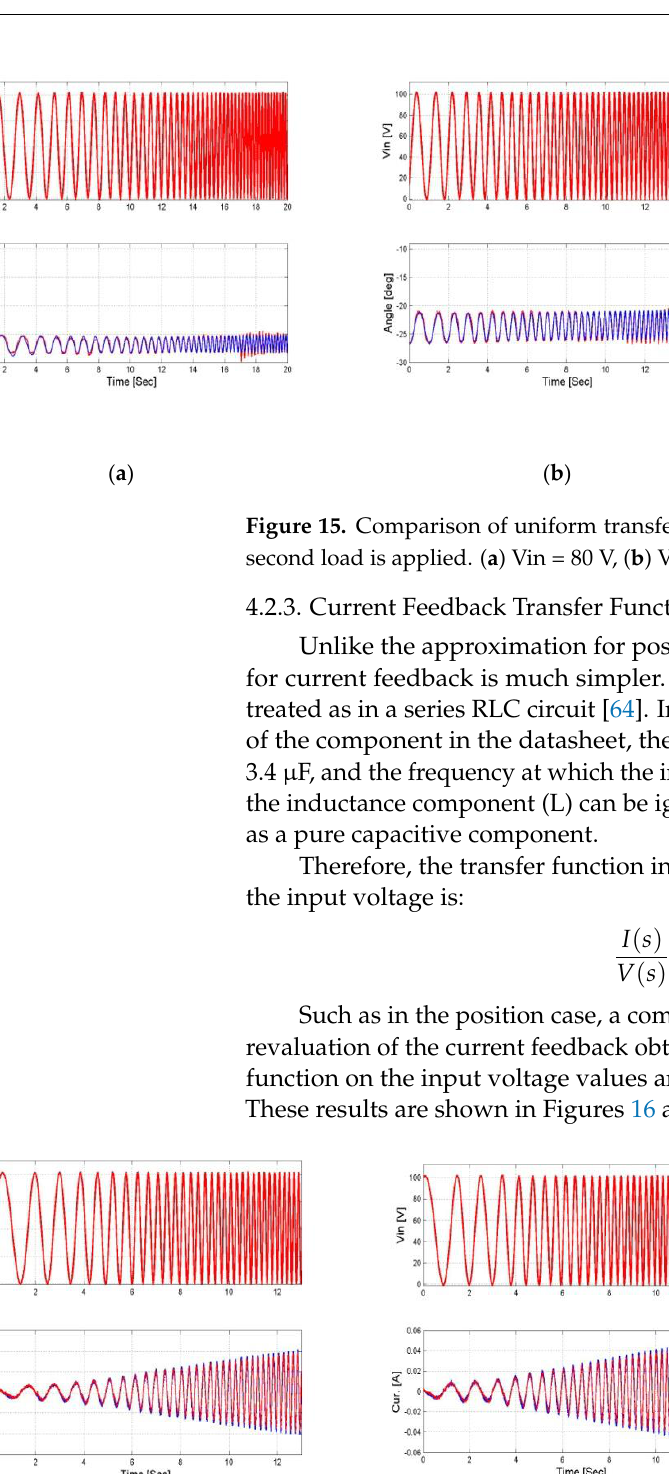
Figure 14. Comparison of uniform transfer function vs. measured output angle results when the first load is applied. ( a ) Vin = 80 V, ( b ) Vin = 100 V, and ( c ) Vin = 120 V.